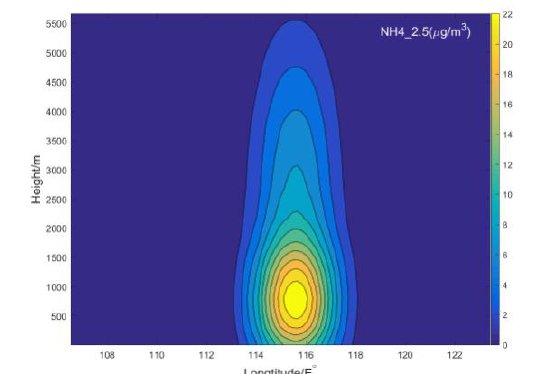
Figure 4 Mass concentrations distribution vertically of the No.4 control variable after data assimilation